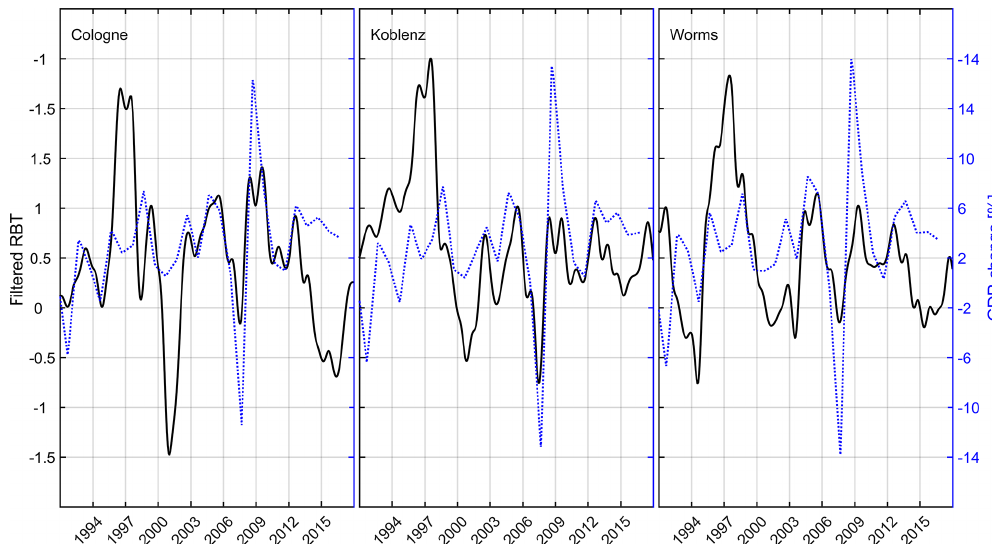
Figure 8. Detrended and filtered RBT signal (black solid) and the GDP change (blue dashed) at Cologne, Koblenz and Worms.